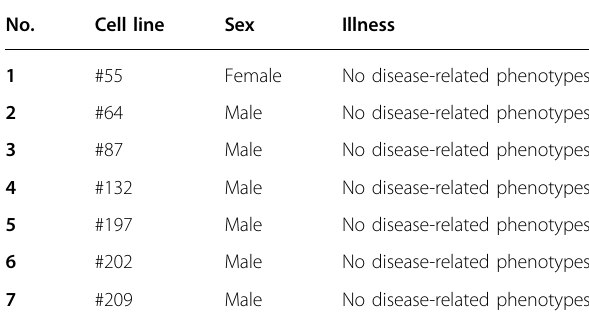
Table 1 General information of hUCB-MSCs